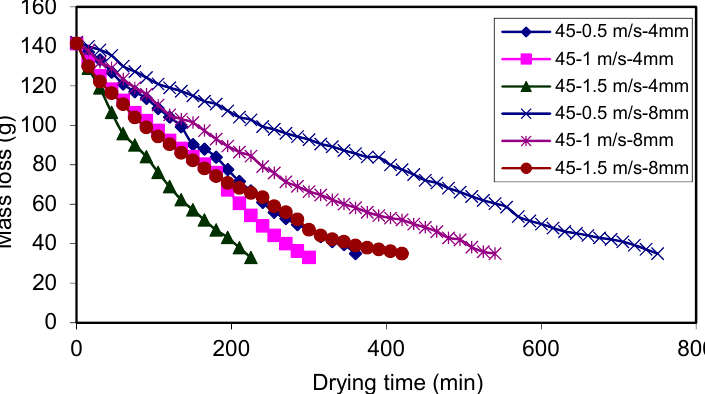
Figure 8. Surface temperature as a function of drying time for drying air velocity of 0.5, 1 and 1.5 m/s and slice thicknesses of 8 mm for kiwi fruits.